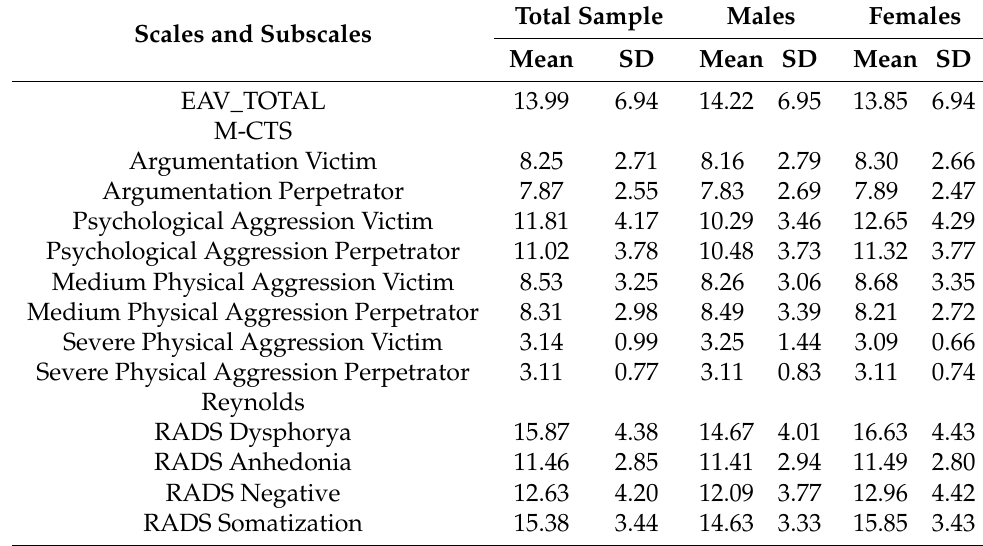
Table 1. Descriptive statistics for the Attitudes Scale Towards Violence (EAV), the Modified Conflict Tactics Scale (MCTS), and the Reynolds (RADS) Subscales for the total sample and across gender.